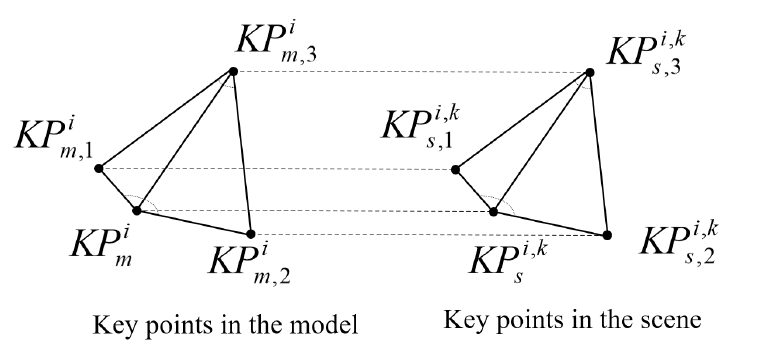
Figure 6. Spatial features of the corresponding key points in the model and scene point